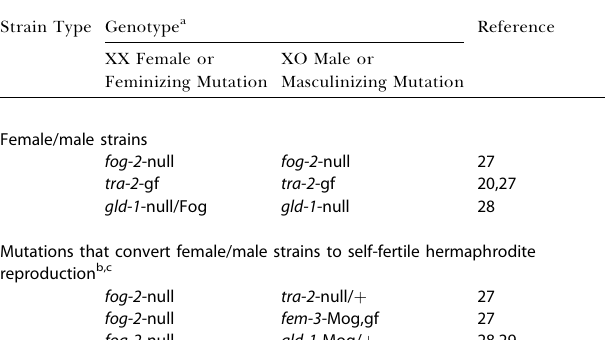
Table 3. C. elegans Sex Determination Mutants That Yield Female/Male Reproduction and Mutually Suppressed Hermaphrodite Reproduction Strain Type Genotype a